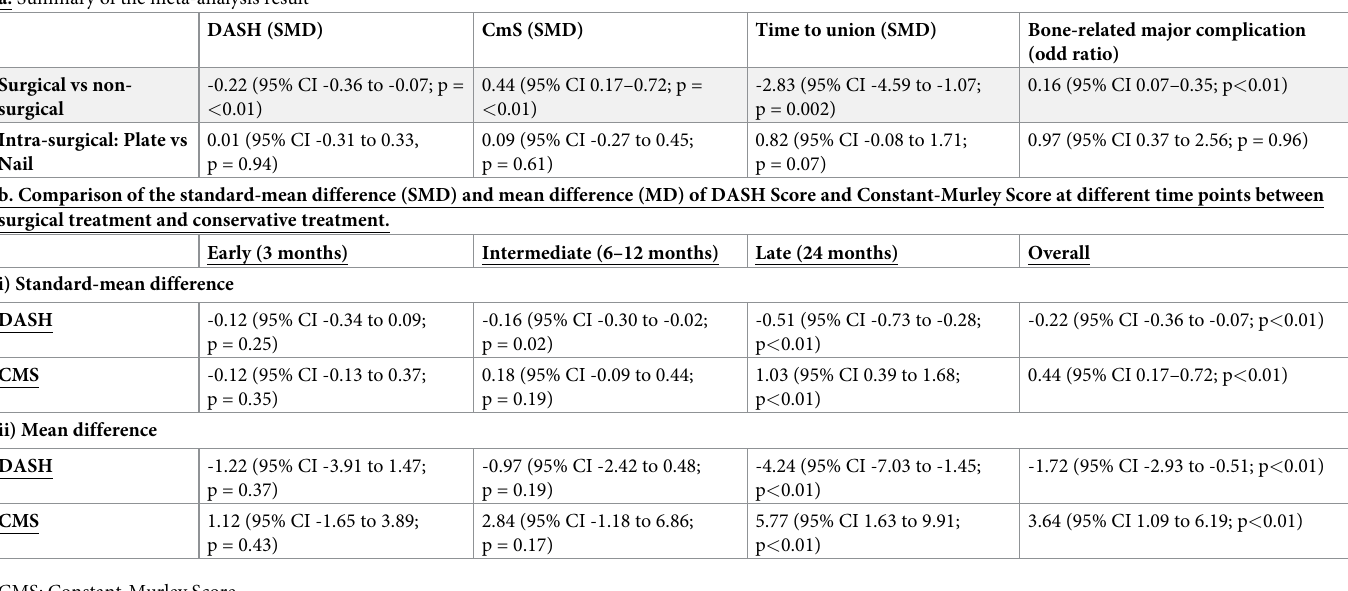
Table 2. a. Summary of the meta-analysis result. b. Comparison of the standard-mean difference (SMD) and mean difference (MD) of DASH Score and Constant-Murley Score at different time points between surgical treatment and conservative treatment.